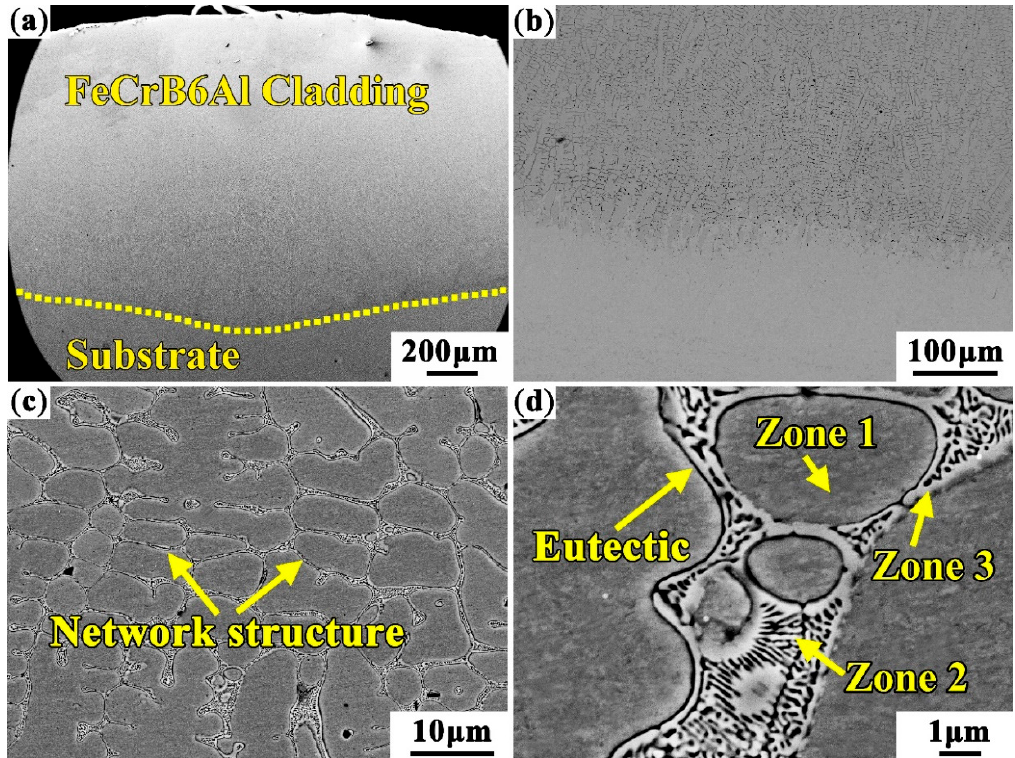
Figure 3. The microstructure morphologies of high aluminum and chromium Fe-B-C coating: ( a ) Macromorphology; ( b ) Bottom of cladding layer; ( c , d ) Middle part of cladding layer. Table 2. Chemical compositions of the phases with different morphologies in high aluminum and chromium Fe-B-C coating (wt.%).